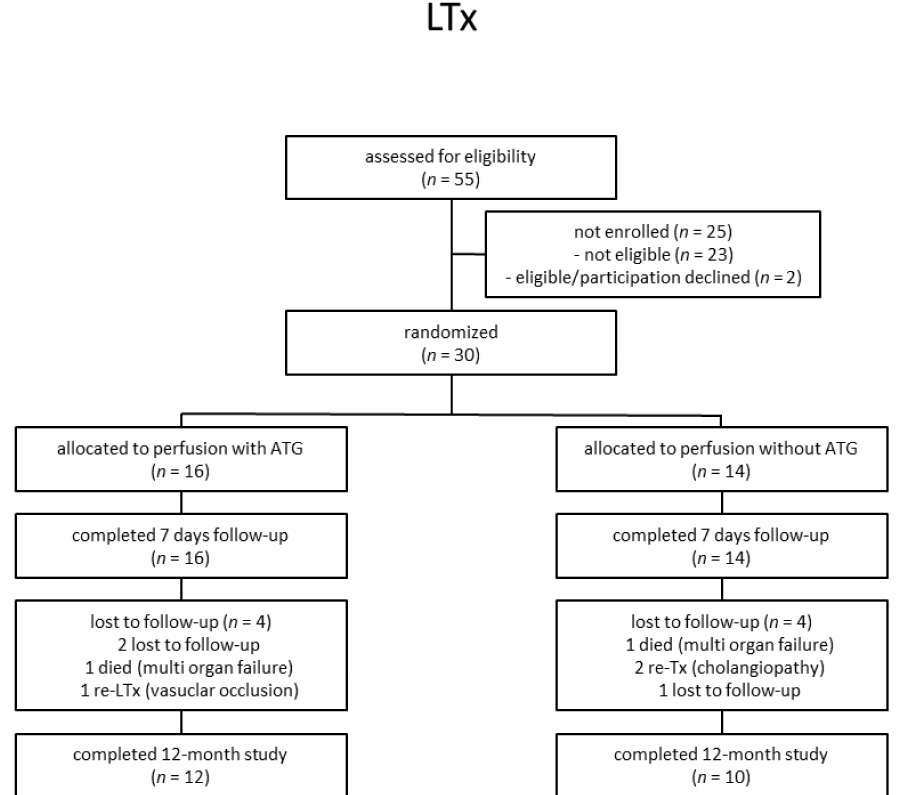
Figure 1. Participant flow